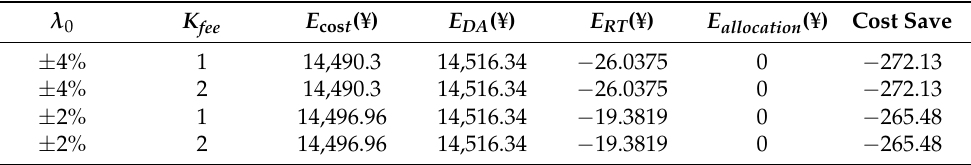
Table 7. Electricity costs with different deviation assessment